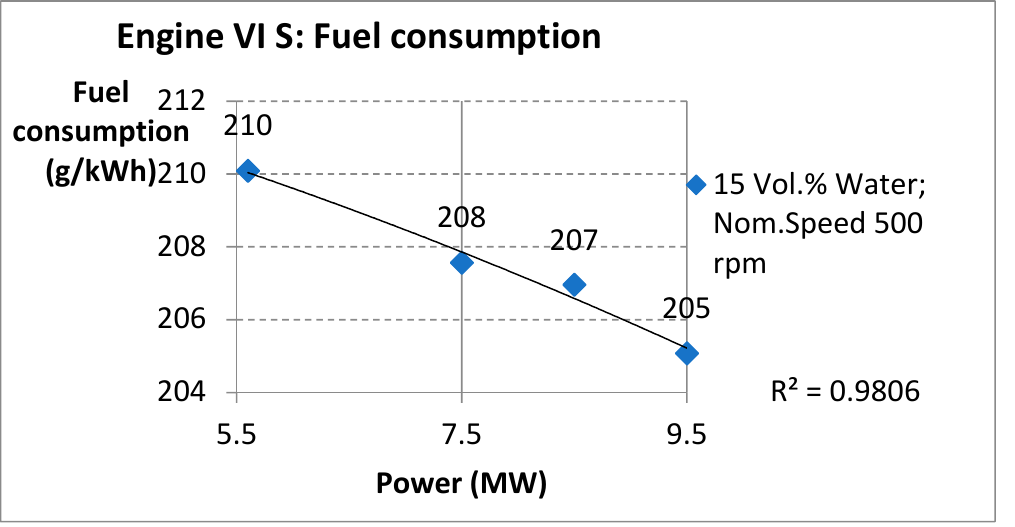
regime. According to Figure 15 the engine operation exceeding 76% of load will improve the fuel economy and efficiency of the combustion process.